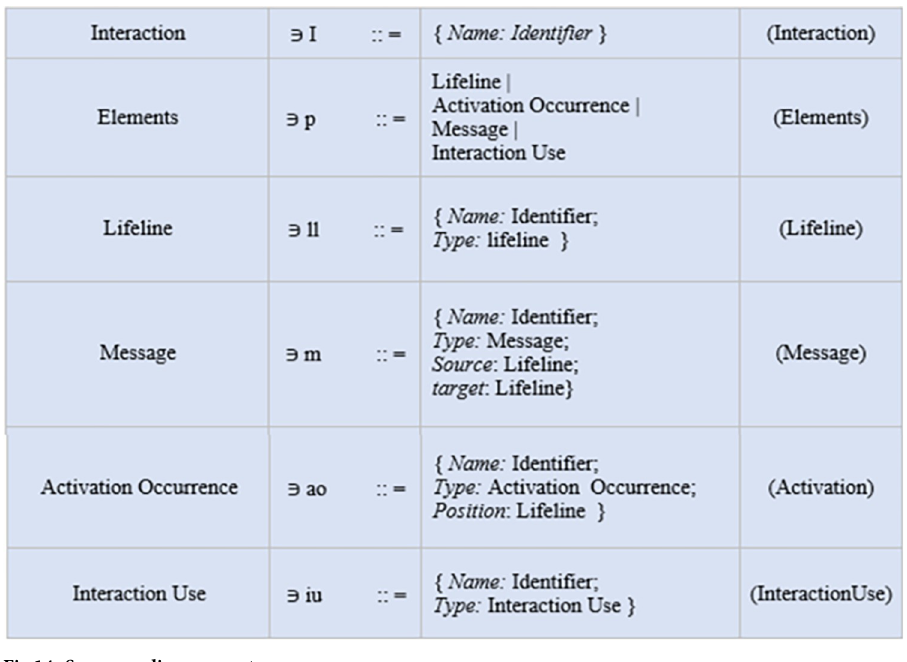
Fig 14. Sequence diagram syntax.